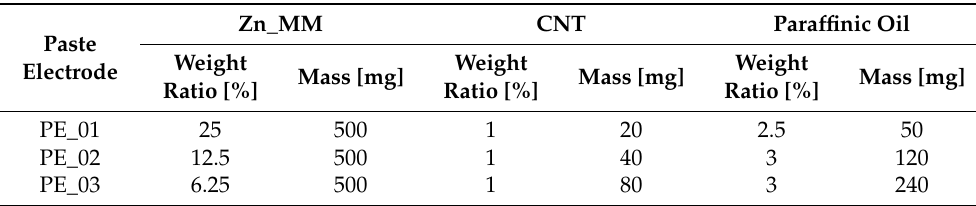
Table 1. Composition of paste electrodes